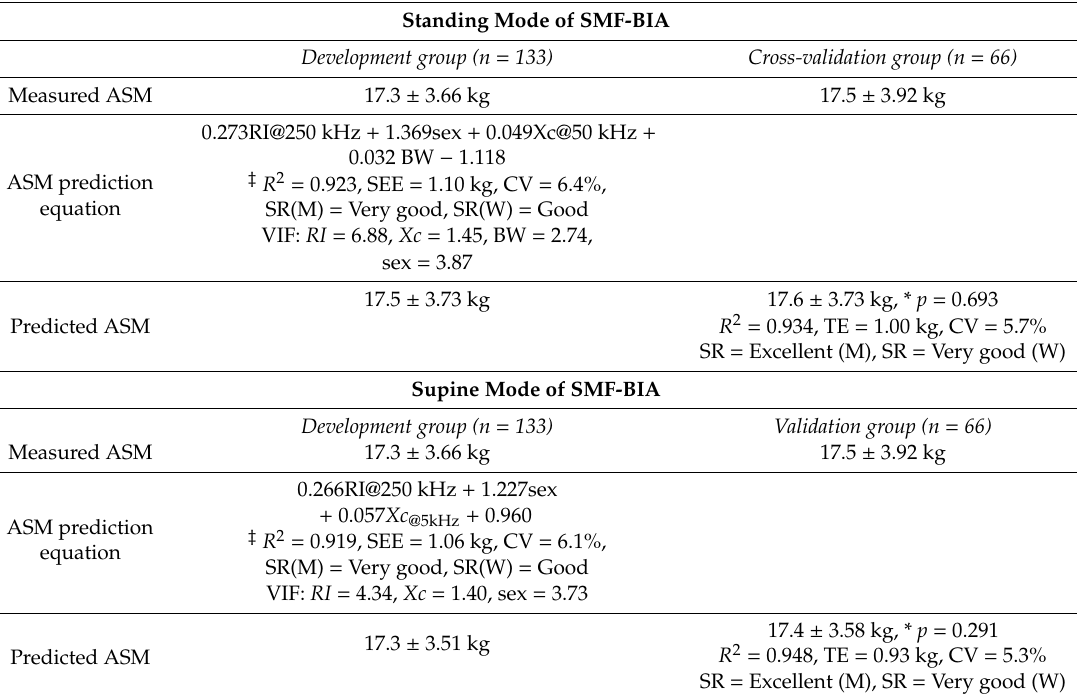
Table 2. Development and validation of predictive bioimpedance analysis (BIA) equations for appendicular skeletal muscle mass (ASM) on Korean older